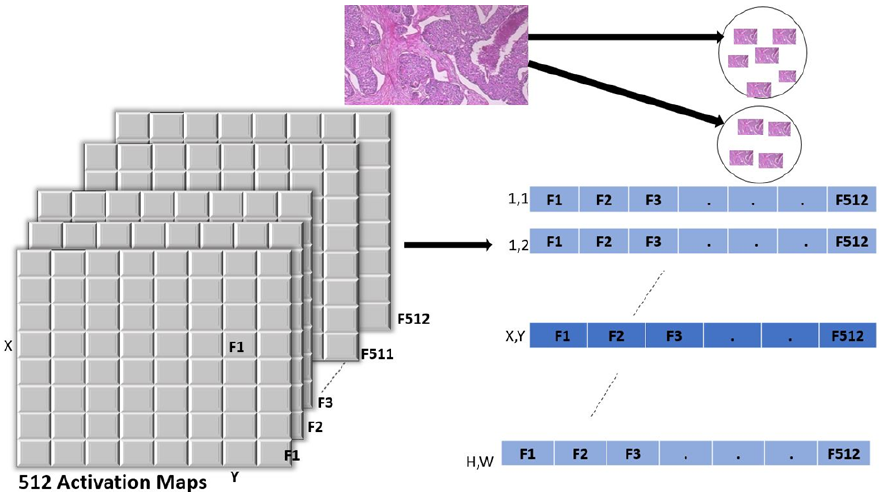
Figure 9. Feature pooling approach to create bag of deep multiresolution convolutional features